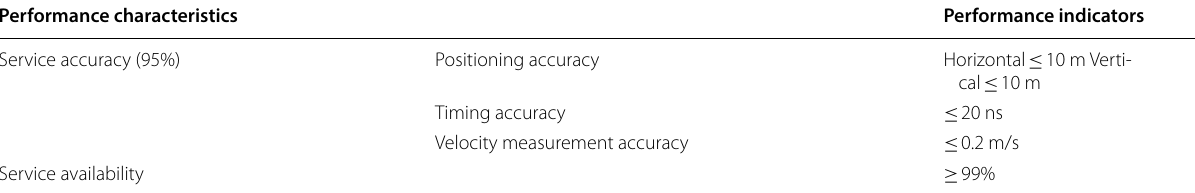
Table 1 Main BDS RNSS Performance Indicators Performance characteristics Service accuracy